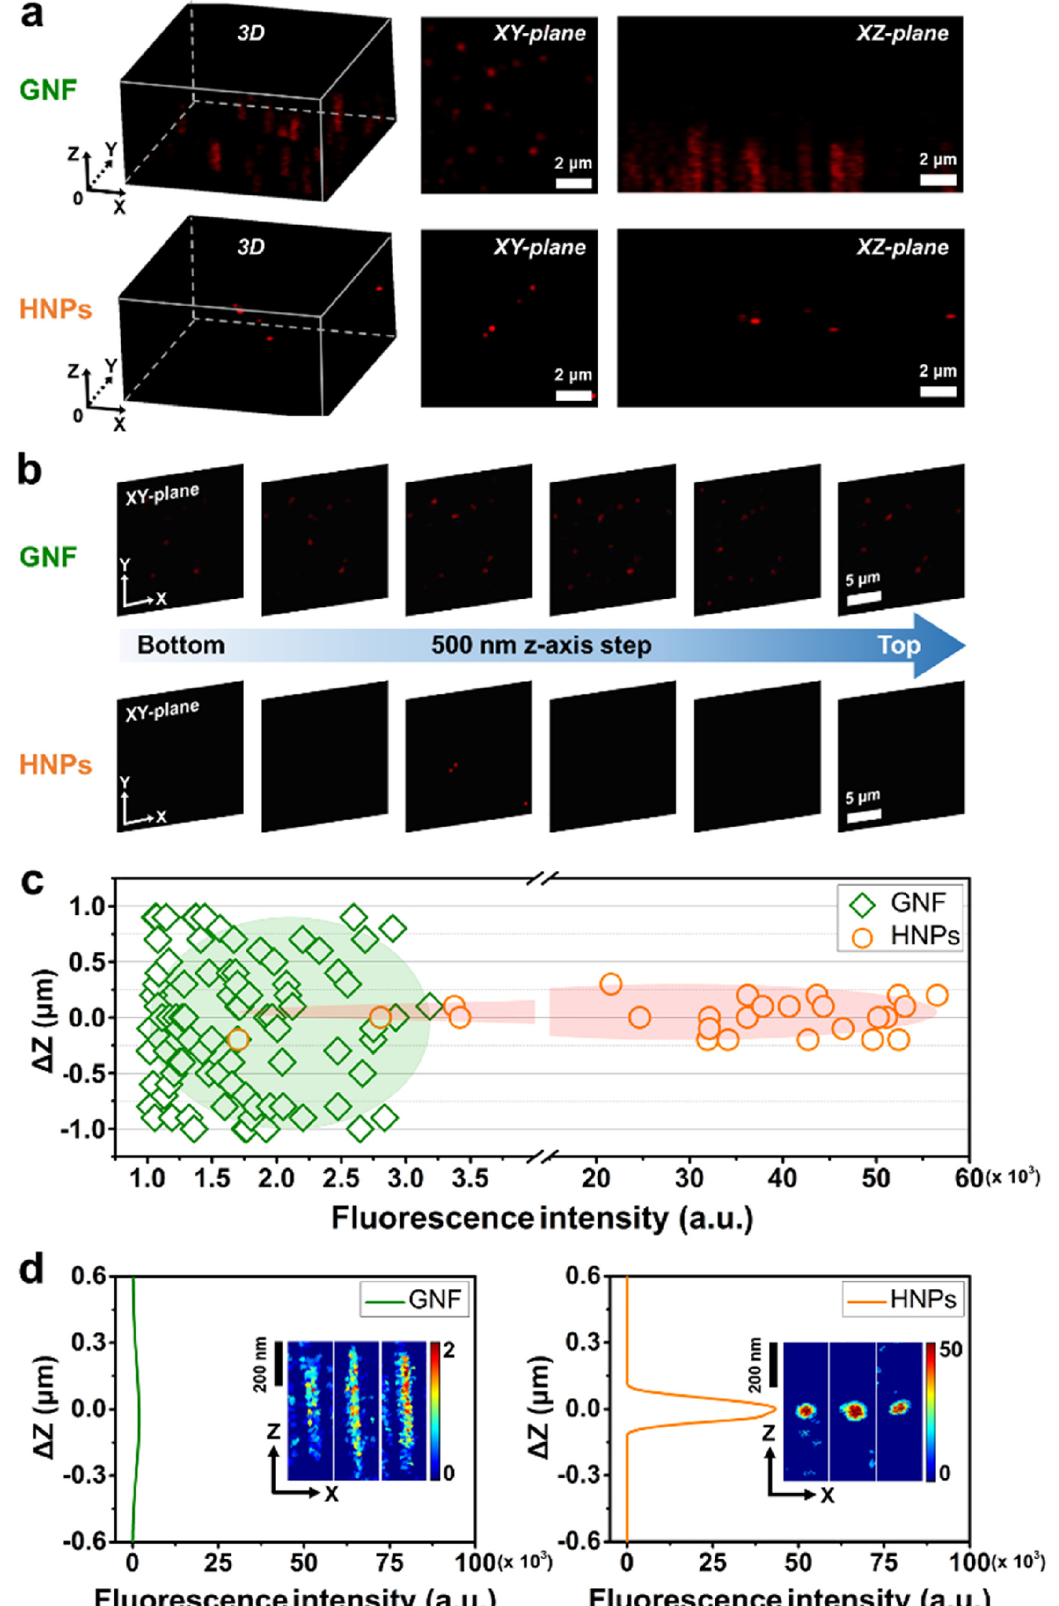
Figure5: AnalysisofaxialresolutionperformanceusingHNP-basedfluorescenceemissioninatwo-photonopticalsystem.(a)Representative3D visualizationofEGFsignalsongoldfilmsandHNPsobtainedviaTPM.(b)Verticalcross-sectionofEGFsignalsontheGNFandHNPsatdifferentz- positions. (c) Fluorescence intensity distribution of EGF signals emitted on gold films and HNPs in 3D images. (d) Intensity plots fitted to a Gaussian curve for estimation of the depth resolution of single fluorescent molecules with a nanoscale size, measured on HNPs and